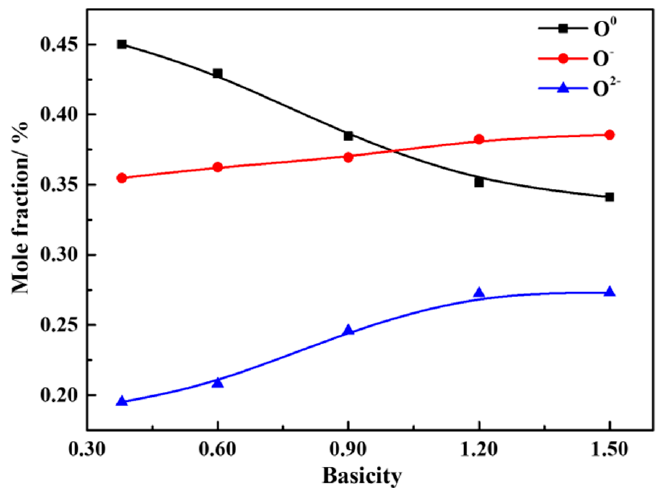
Figure 15. Curve of the mole fraction of different kinds of oxygen atoms with the basicity. Equation (1) is a fundamental result of the charge balance required by the tetrahedral co-ordination of oxygen with silicon, and when any silicate anions associate to form higher polymers plus oxygen ions, the overall reaction reduces to Equation (1).